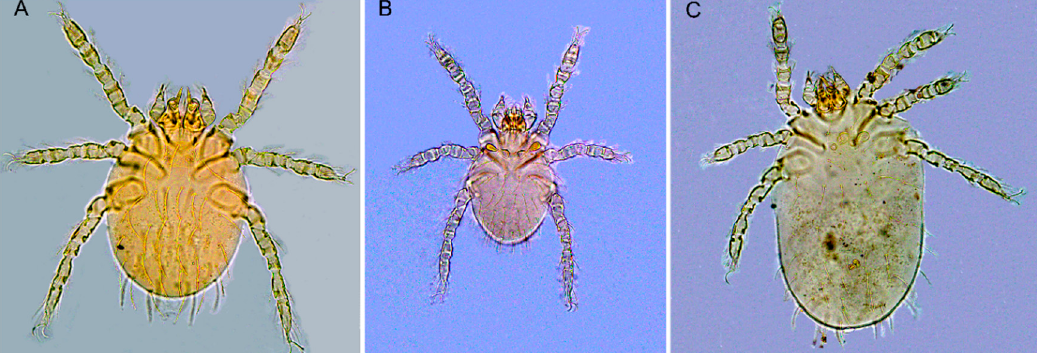
Figure 2. Photos of three dominant chigger species (10 × 40) on Rattus tanezumi . (( A ) = Leptotrombidium deliense , ( B ) = Ascoschoengastia indica , and ( C ) = Walchia ewingi ).